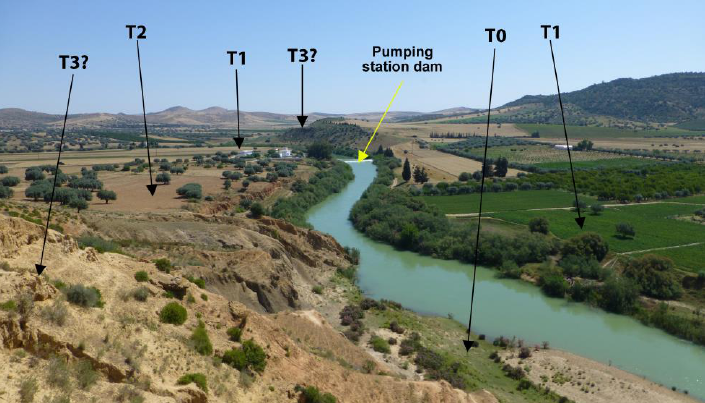
Figure 4. River Medjerda terraces in the vicinity of the pumping station (about two kms downstream from the Sidi Salem dam): (T0) flood zone and river bars; (T1) low terrace (Holocene); (T2) upper Pleistocene terrace; (T3) middle Pleistocene terrace(?). Source: